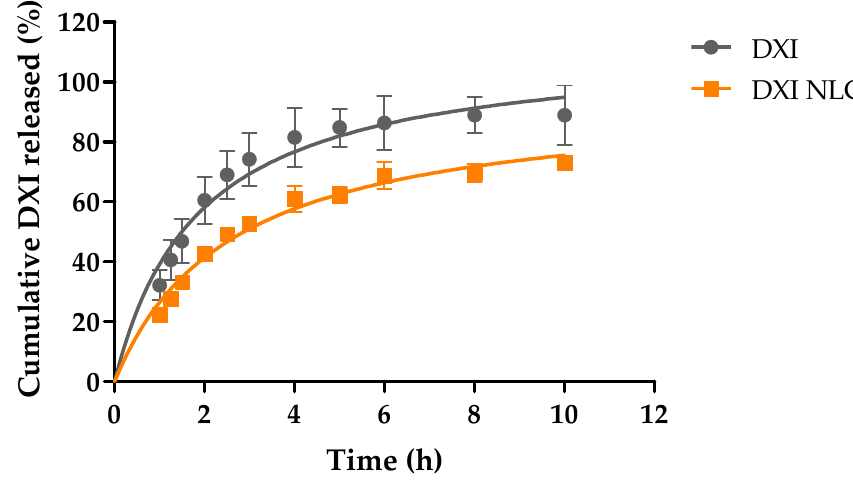
Figure 7. Released profile of free DXI and DXI-loaded nanostructured lipid carriers (DXI-NLC) after 10 h of incubation, adjusting the data to a hyperbola equation.